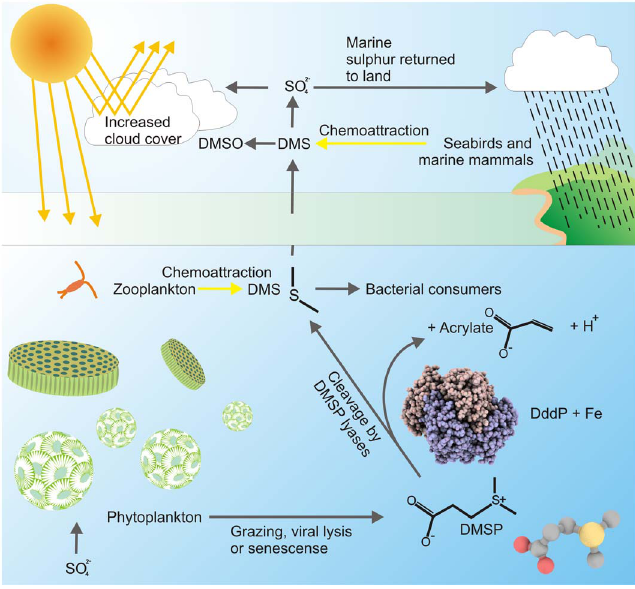
Figure 1. Microalgae produce DMSP; microbial lyases cleave DMSP into DMS, a process with relevant biogeochemical ramifications. (Adapted from [1]). A complete depiction of catabolic processing of DMSP by microbes is detailed in [6].